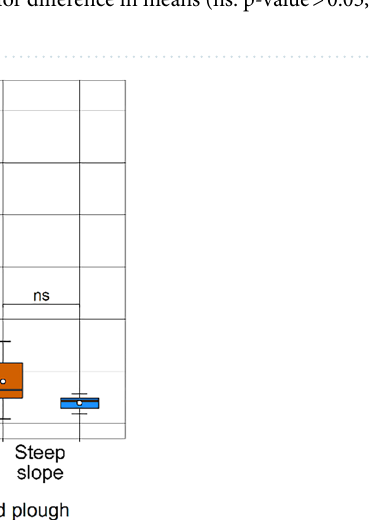
Figure 7. Boxplots of k til [kg m −1 pass −1 ] for the three experimental sites with gentle, moderate, and steep slope calculated based on slope segments. Boxes indicate 1st quartile, median and 3rd quartile, whiskers indicate ± 1.5 times the inter-quartile range, while dots represent data beyond the end of the whiskers. White circles indicate mean values per boxplot. Stars denote significance levels of the Wilcoxon rank sum test for difference in means (ns: p-value > 0.05, *: p value < 0.05, **: p value < 0.01, ***: p value <